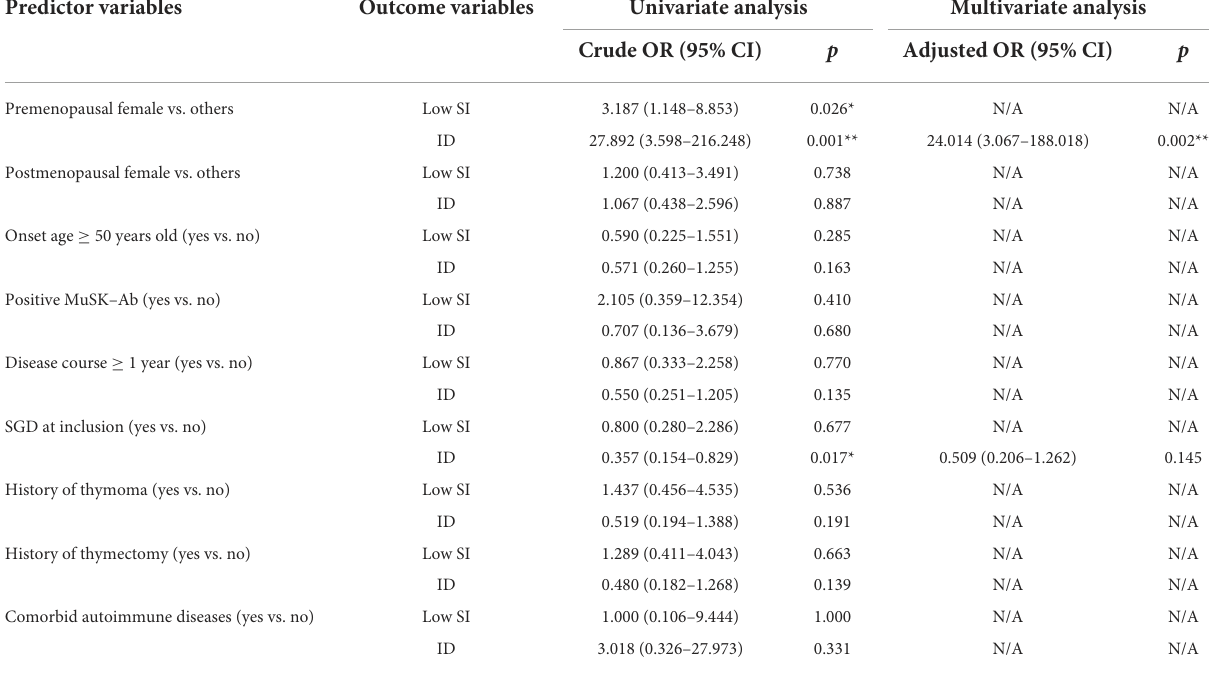
TABLE 3 Potential predictors of low SI or iron